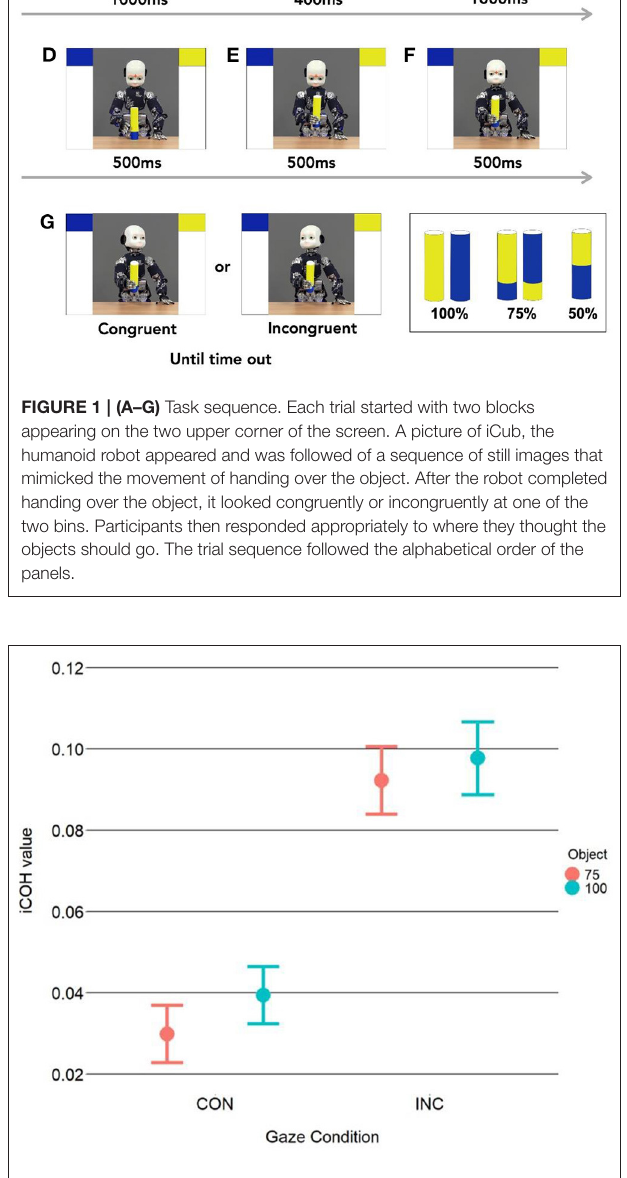
first half of the experiment (M = 412 ms, SD = 73.4)